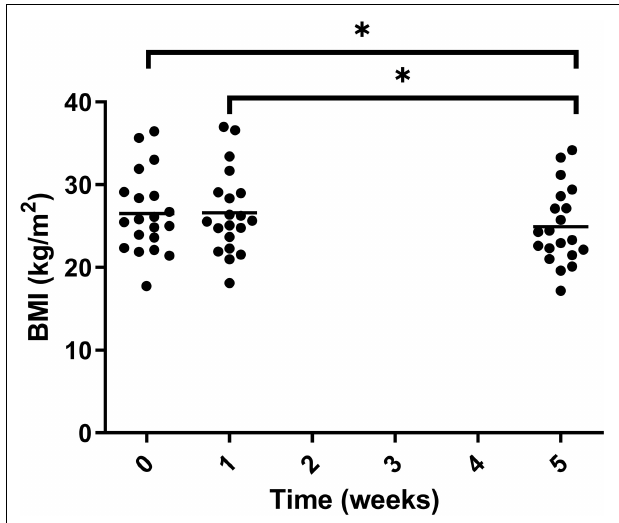
FIGURE 11 | BMI of participants at the three timepoint measured during the trial. Week 1 represents a second measurement after a control week of normal diet. Week 5 represents a third measurement after 4 weeks of a 100% Huel diet. There was a significant difference between weeks 0 vs. 5 and 1 vs. 5. Asterisks denote statistical differences between means.